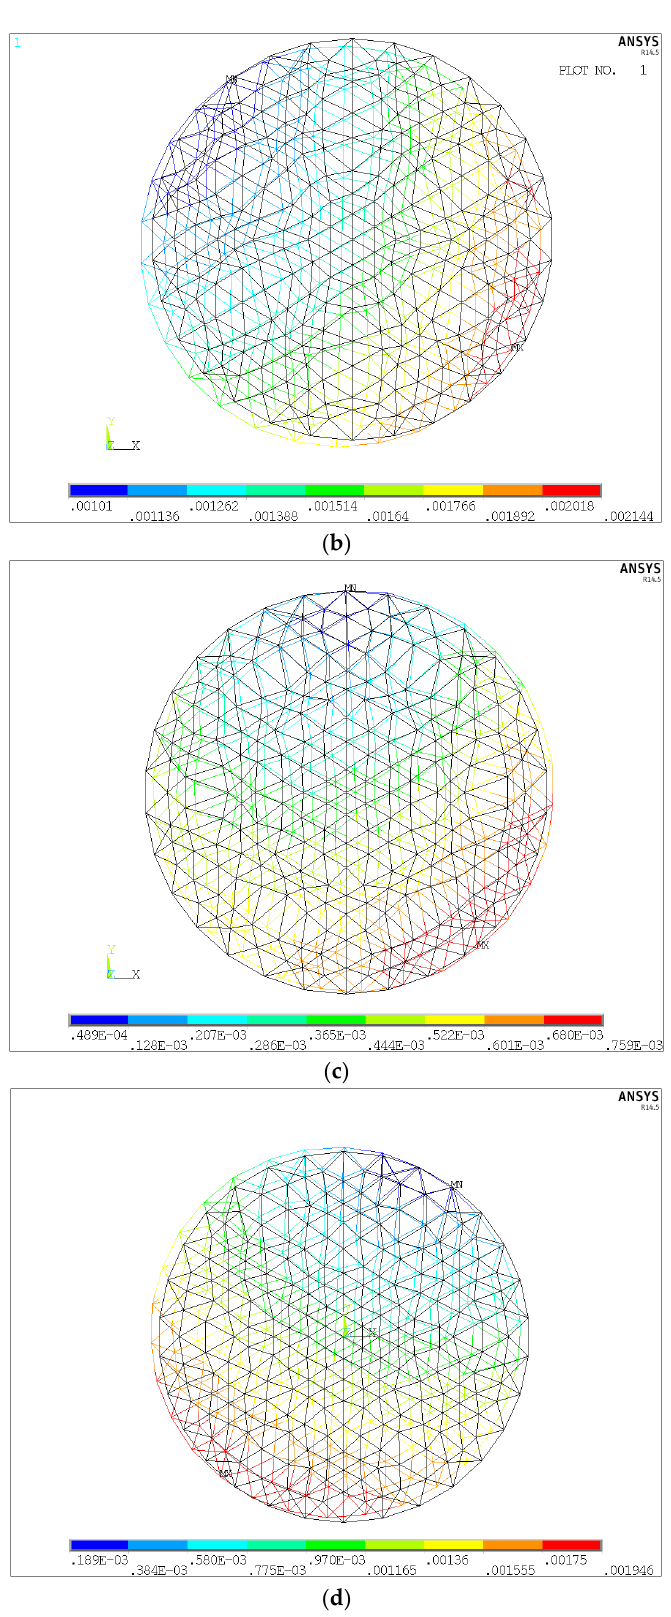
Figure 10. The contour nodal displacement solution of the front reflector: ( a ) the initial iteration, ( b ) the first iteration, ( c ) the second iteration, and ( d ) the third